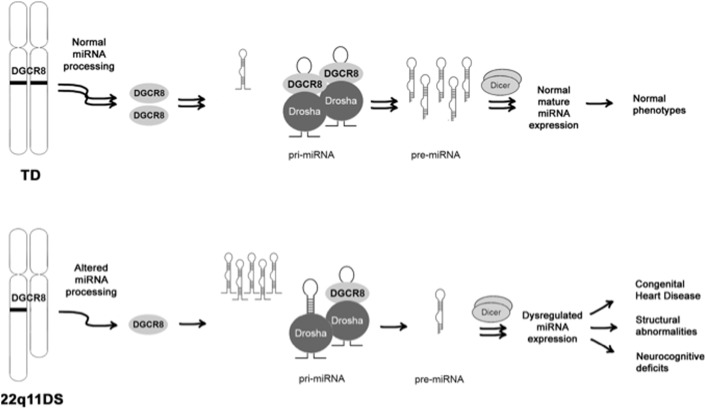
Proposed model of miRNA dysregulation in 22q11DS.Decreased levels of free DGCR8 results in dysregulated expression of mature miRNAs, ultimately leading to development of the clinical phenotypes associated with 22q11DS.